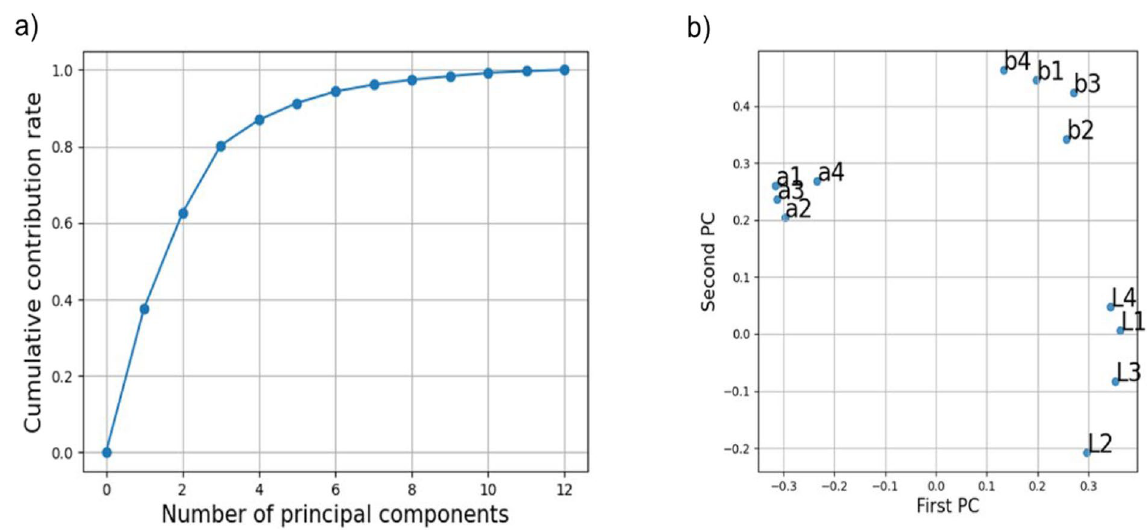
Figure 7. Result of the principal component analysis (PCA) of the tongue color. ( a ) Cumulative contribution rate of the principal components (PCs). ( b ) The distribution of factor loadings for the first and second principal components of the 12 color values is shown, where L, a, and b represent L*, a*, and b* values, and the numbers represent tongue regions (1:edge, 2:posterior, 3:middle,